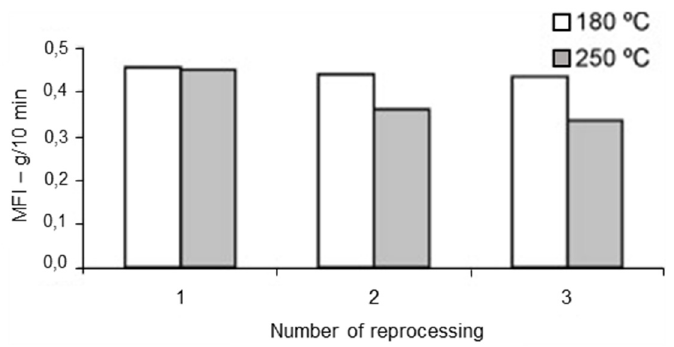
Figure 8. MFI of rPP/rHPDE 90/10 wt% blend reprocessed under conventional and aggressive temperature conditions. Reproduced with permission [148].